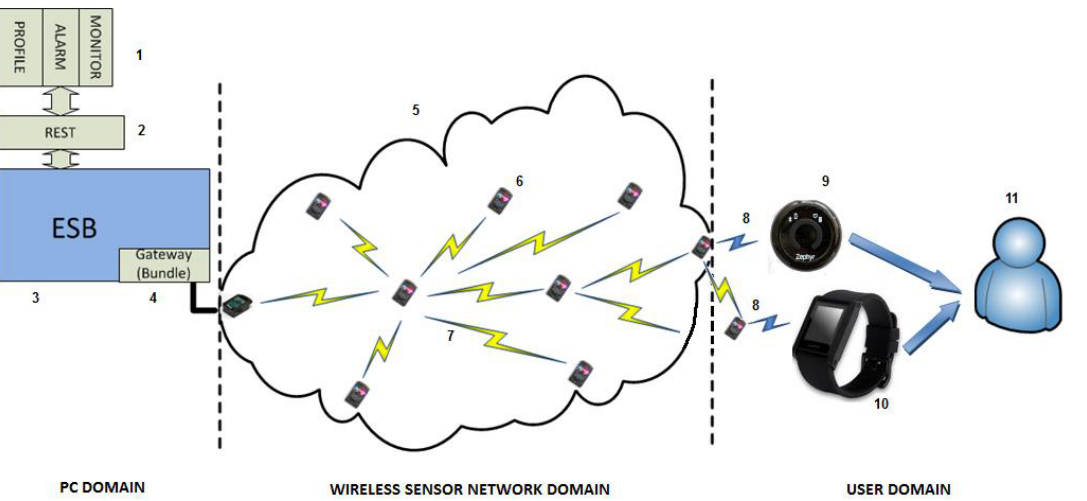
Figure 7. A holistic view of the